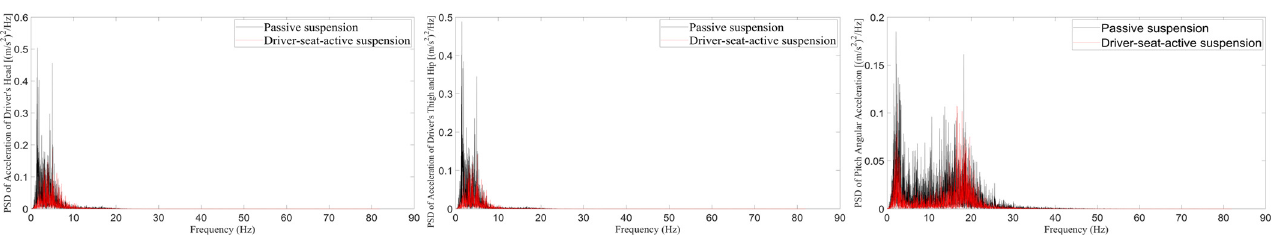
Figure 10. The power spectral density function of the performance indexes.